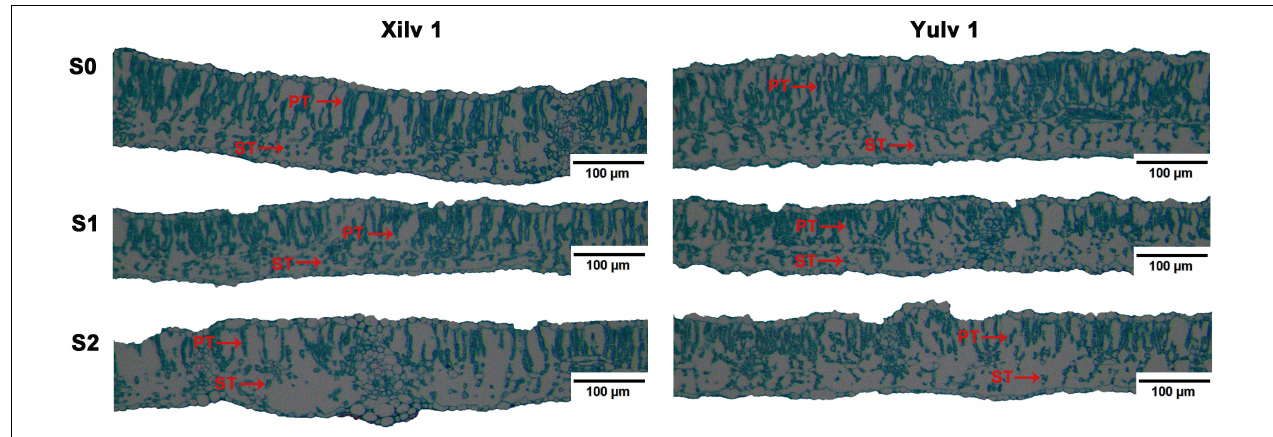
FIGURE 7 | Effect of shading stress on the leaf anatomical features in mung bean. ST, spongy tissues; PT, palisade tissues. S0, no shading; S1, moderate shading; and S2, severe shading.